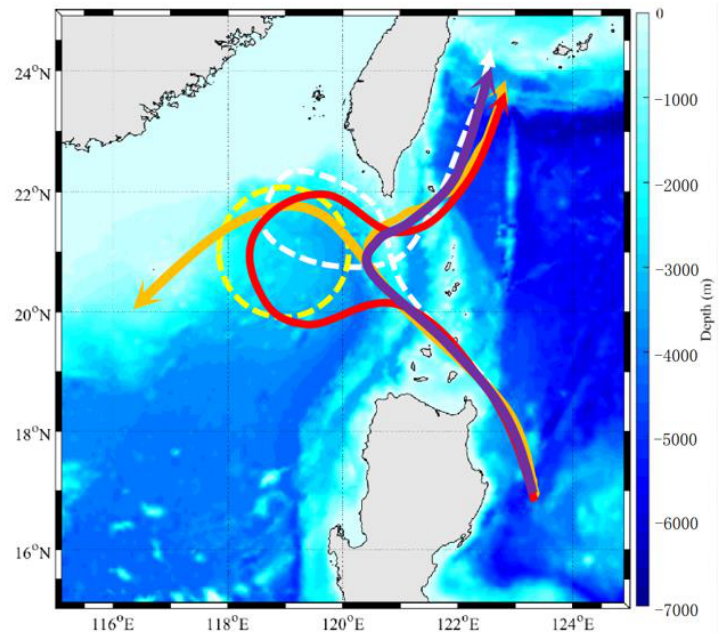
Figure 1. Topography of the study area. The color contours denote bathymetry (m). The solid and dashed lines represent five main paths of Kuroshio. Purple solid line represents leaping across. Yellow solid line represents branch intruding. Red solid line represents an anticyclonic loop current that penetrates into SCS before returning to the main axis of the Kuroshio. Yellow dashed line represents eddy shedding. White dashed line represents a cyclonic loop current that penetrates into SCS before returning to the main axis of the Kuroshio.